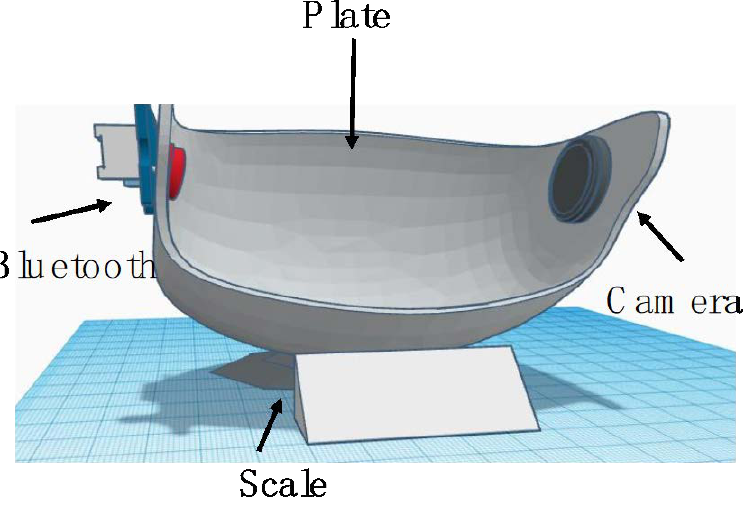
Figure 4. The 3D model for the plate.